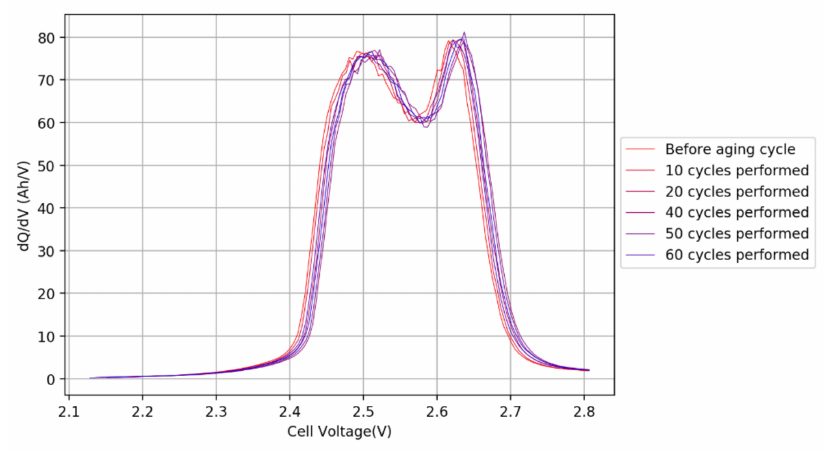
Figure 12. The IC curves of cell No.2 at 2C during aging